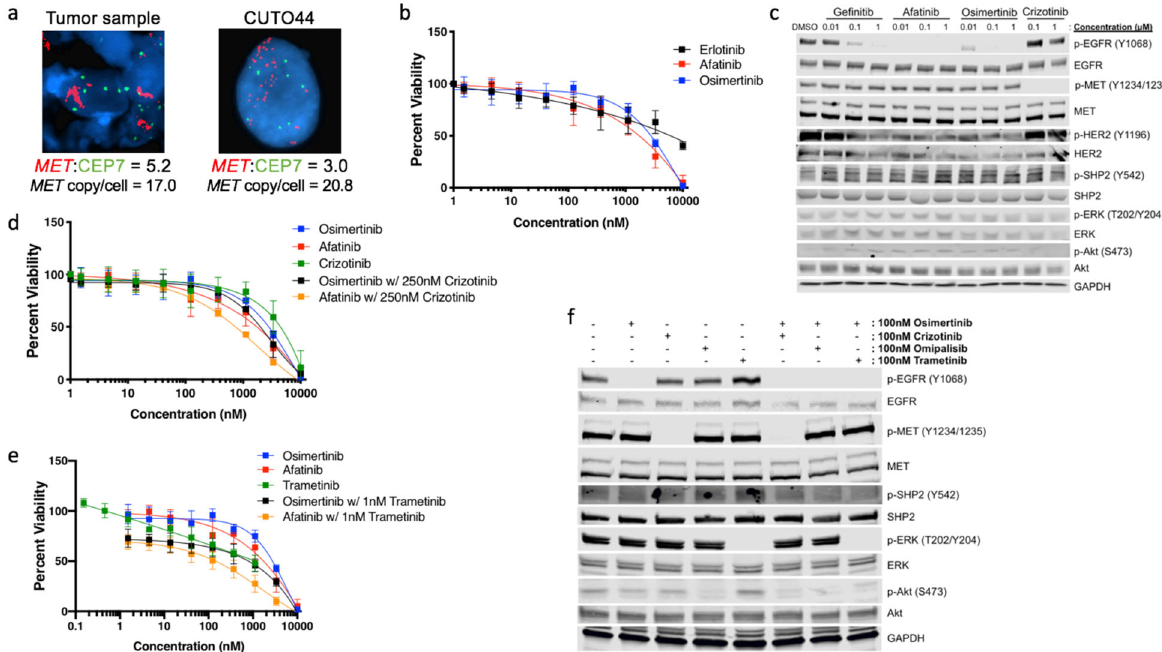
Fig. 2 CUTO44 cell line is resistant to single-agent EGFR inhibition but sensitive to combination with crizotinib or trametinib. a MET FISH analysis of the patient tumor sample upon progression on erlotinib (left) and the CUTO44 cell line (derived from the same biopsy, right) showing MET probes labeled in red and the chromosome 7 centromere probes in green. b Cell proliferation inhibition following treatment with erlotinib, afatinib, or osimertinib. CUTO44 cells were treated with the indicated concentration of drugs for 72 h and proliferation was measured by MTS assay. Showing the mean ± SD, n = 3 biological replicates. c Western blot showing downstream signaling changes following treatment with EGFR inhibitors and crizotinib. CUTO44 cells were treated with the indicated drugs for 2 h before lysis and protein analysis by western blot. Showing representative images, n = 2. d Cell proliferation following treatment with crizotinib and the combination with EGFR inhibitors. Same as in b . e Cell proliferation inhibition of cells treated with trametinib and the combination with EGFR inhibitors. Same as in b . f Western blot showing downstream signaling changes following drug combination treatments. Same as in c with drugs combined at the indicated